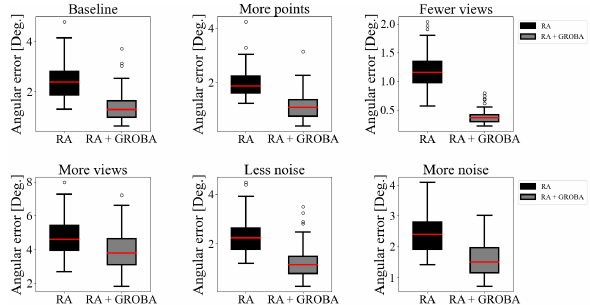
Figure 4: Results of the synthetic data test settings. Comparison between RA and G-ROBA (initialized by RA) in terms of the mean angular error after the L 1 alignment.